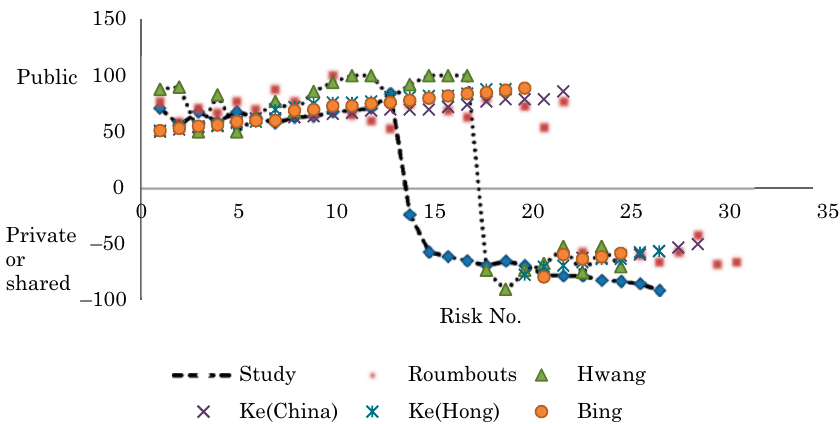
Fig. 5. Results of application of proposed model in comparison with previous studies